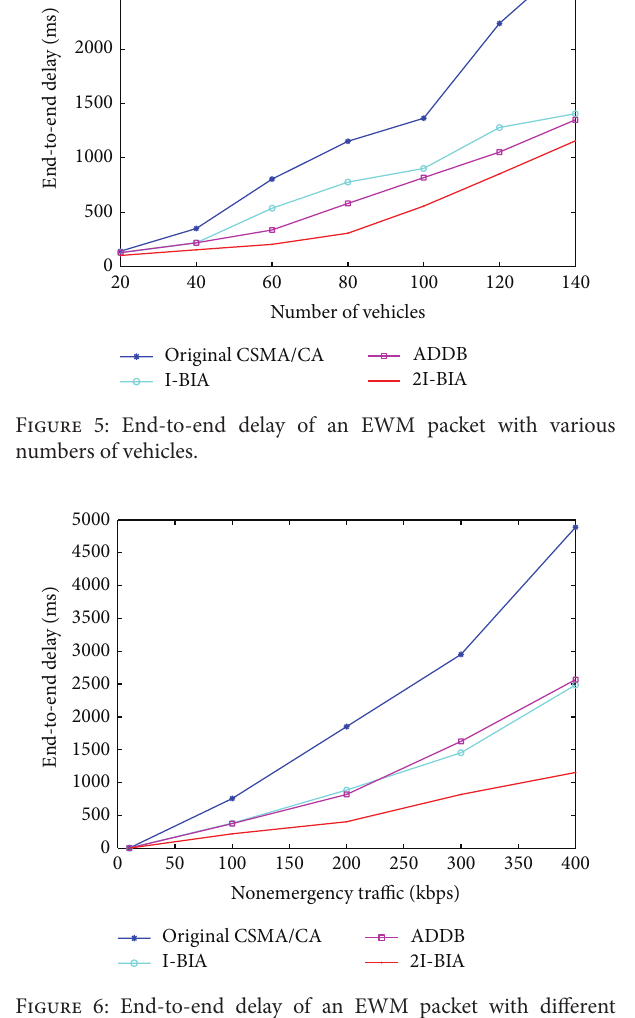
Figure 6: End-to-end delay of an EWM packet with different nonemergency traffic